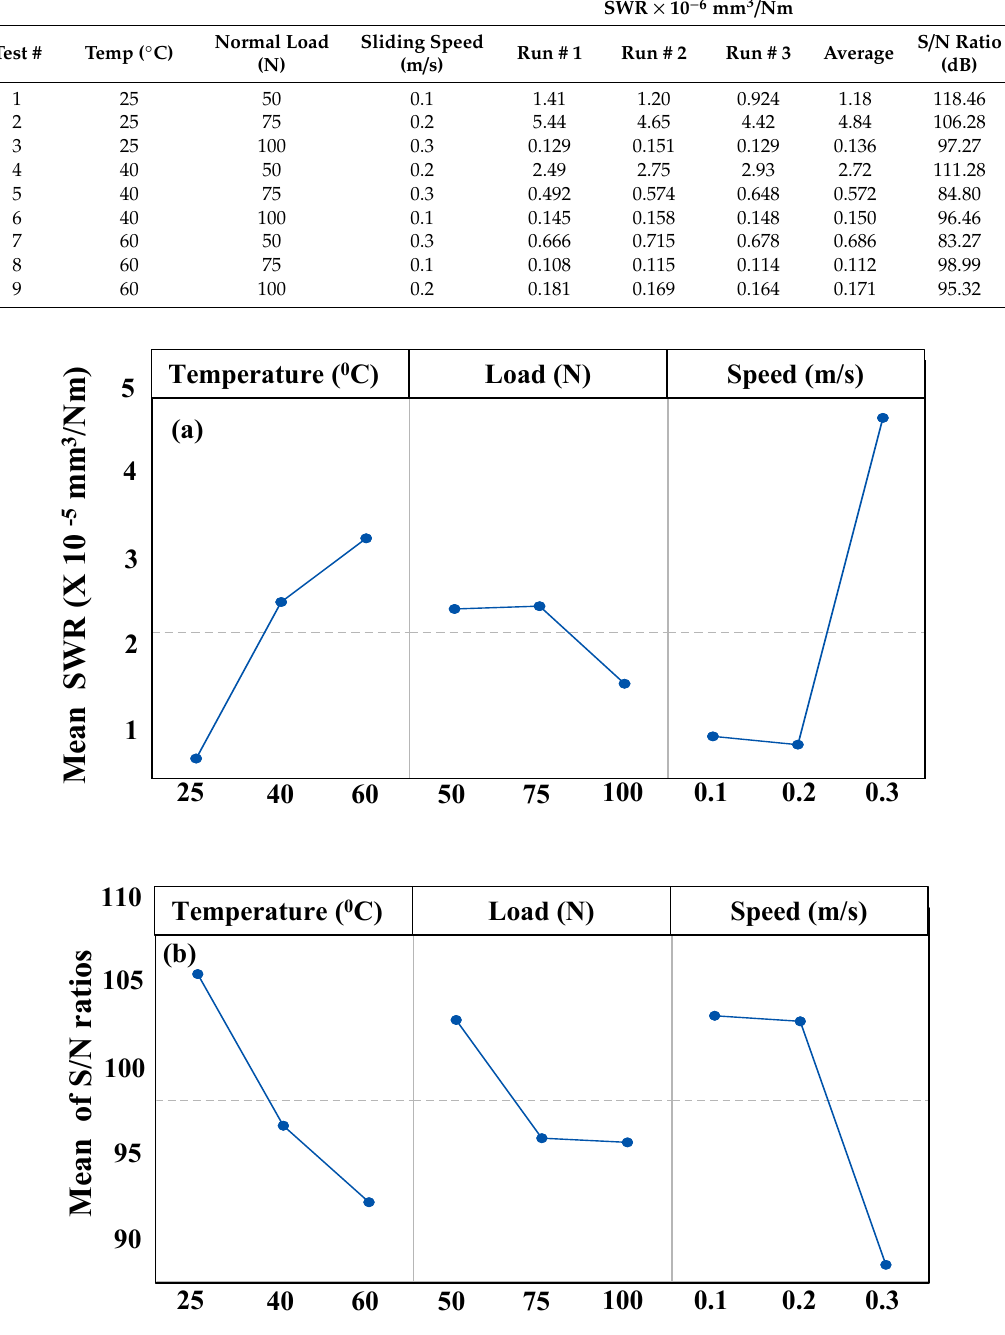
Figure 3. ( a ) main e ff ects plot for the specific wear rate; ( b ) main e ff ects plot for the mean S / N ratios, smaller is